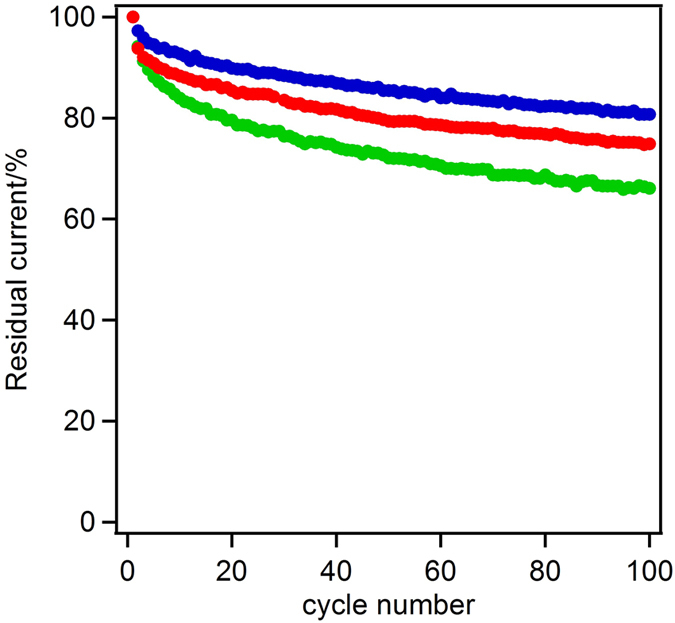
Stability of the electrode response during rotation at 10,000 rpm for the various pore morphologies (macropore/mesopore ratio) at 15 °C. MgOCmeso (blue), MgOCmacro (green), and MgOC33 (red).